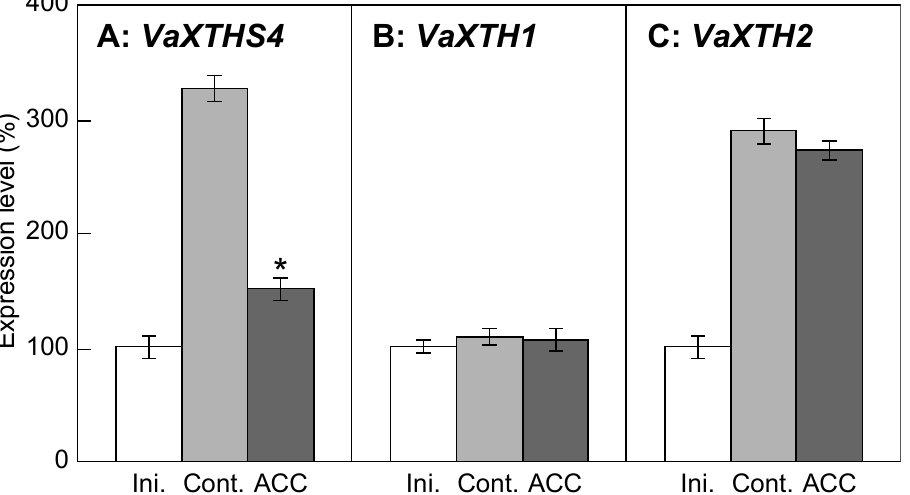
Figure 5. Gene expression of XTH s of ACC-treated azuki bean epicotyls. ACC treatment was carried out in accordance with the parameters shown in Figure 1. The gene expression of VaXTHS4 ( A ), VaXTH1 ( B ) and VaXTH2 ( C ) was determined using a real time RT–PCR. The values were corrected for the levels of 18S rRNA as an internal standard and represented as the percentage of the initial levels. Values are presented as the means ± SE ( n = 3). * p < 0.05, mean with significant differences between control and ACC treatments.